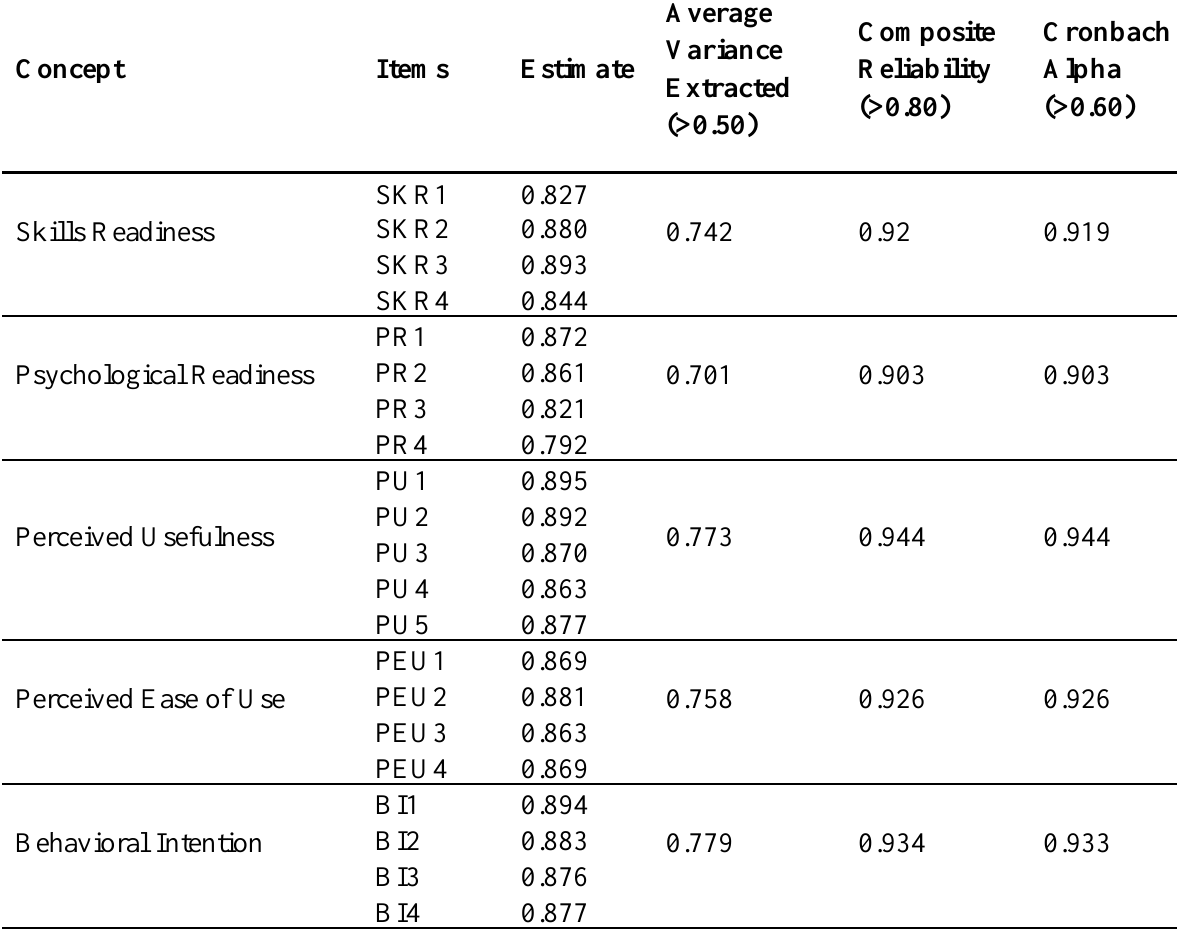
Results of Confirmatory Factor Analysis, Validity Analysis, and Reliability